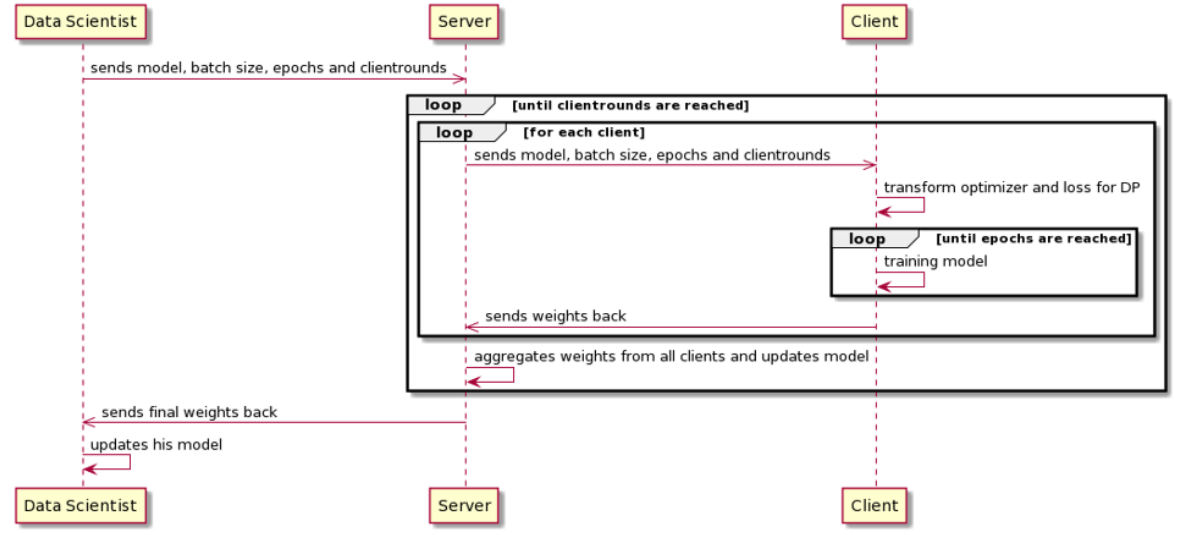
Figure 2. Workflow of FL-DMX training: The data scientist defines his/her model architecture and training configuration and sends it along with the data request to the server, which coordinates the training. The server forwards the architecture and configuration to the clients, which train the model in parallel. First, they transform the optimiser and loss of the model with their DP parameters before the training is carried out. For each round, the weights are sent back and averaged by the server. This is an iterative process until the client rounds are reached. Finally, the server sends the weights back to the data scientist, who updates his/her